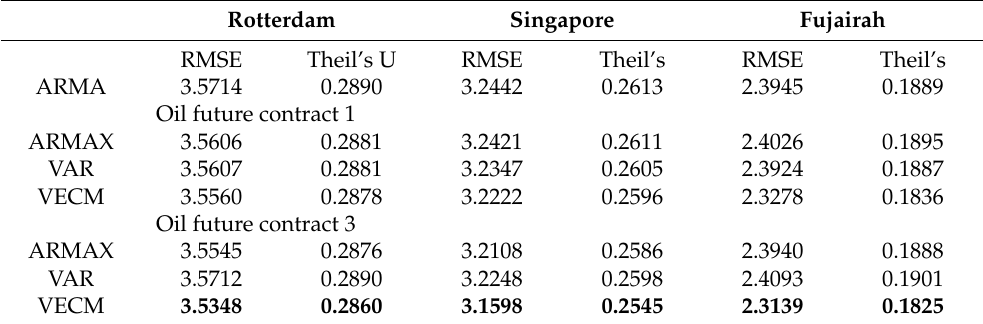
Table 9. 4-step-ahead Prediction Performance (17 July 2020–26 November 2021, 72